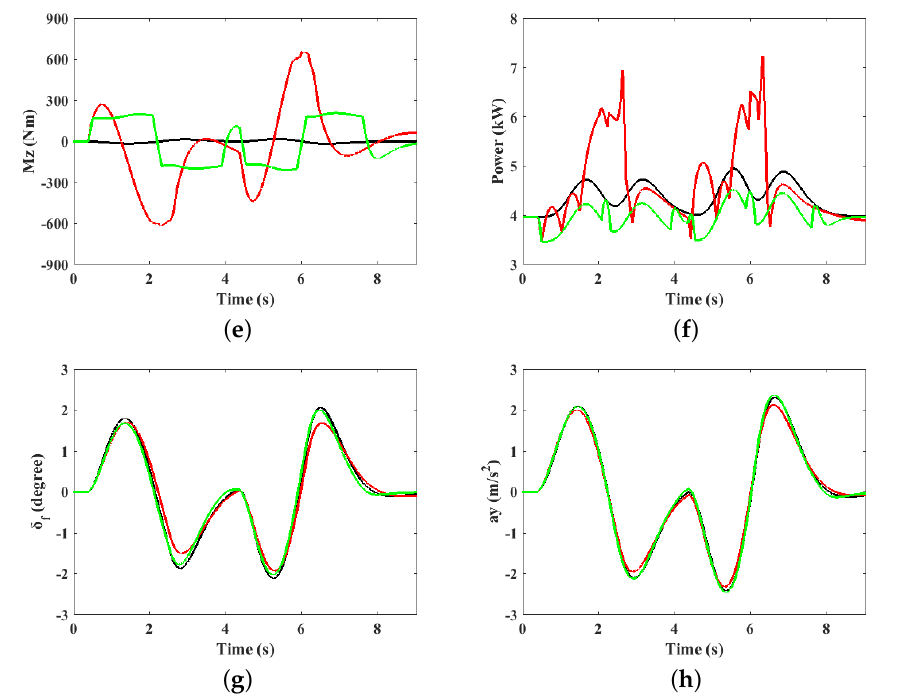
Figure 14. ISO 3888-1 double lane change with Motor II and v x = 50km/h: ( a ) Path; ( b ) Longitudinal velocity; ( c ) Working area; ( d ) Wheel torques; ( e ) Yaw moment; ( f ) Power; ( g ) Front steering angle; ( h ) Lateral